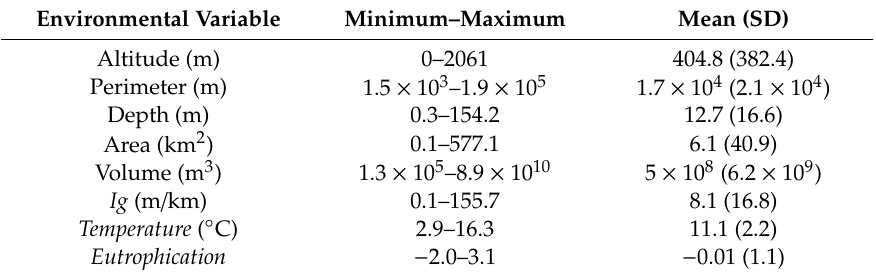
Table 1. Characterization of the environmental variables of the lakes